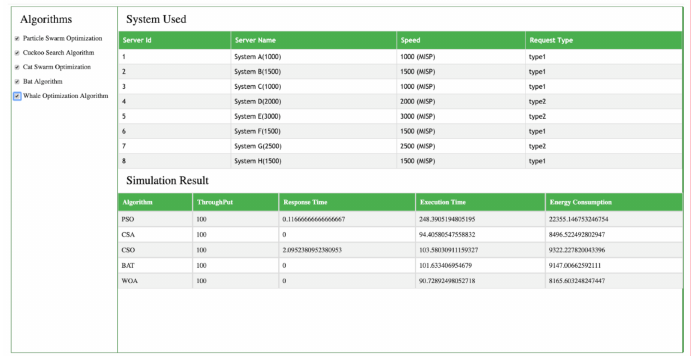
Figure 9. Algorithm results with eight